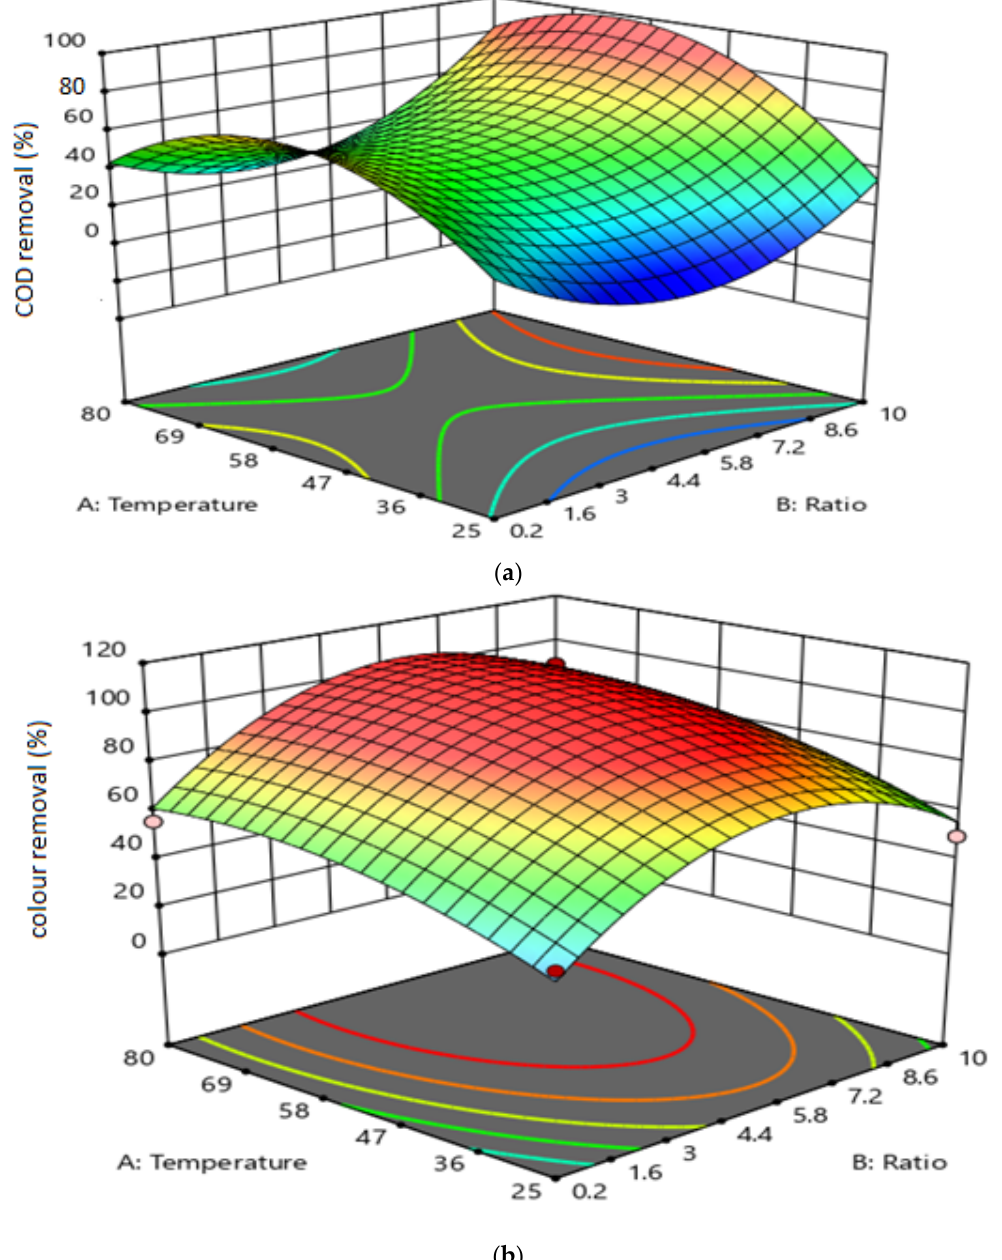
Figure 2. The 3D response surface plots showing the effect of temperature vs. persulfate on ( a ) color removal and ( b ) COD removal (reaction time = 120 min).